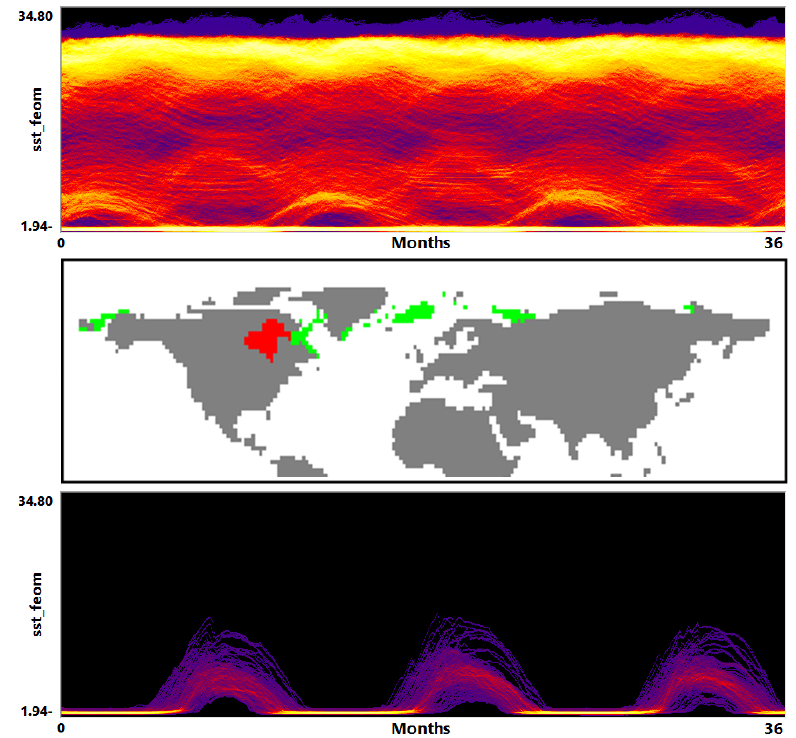
Figure 18. ( top ) Function plot for sea surface temperature aggregated over all climate simulation runs exhibits annual patterns of 3 years. ( middle ) Interactive selection of spatial region of interest (red) and display of similarly behaving spatial regions (green) using information from the function plot. ( bottom ) Function plot for sea surface temperature when filtering the trajectories according to selected